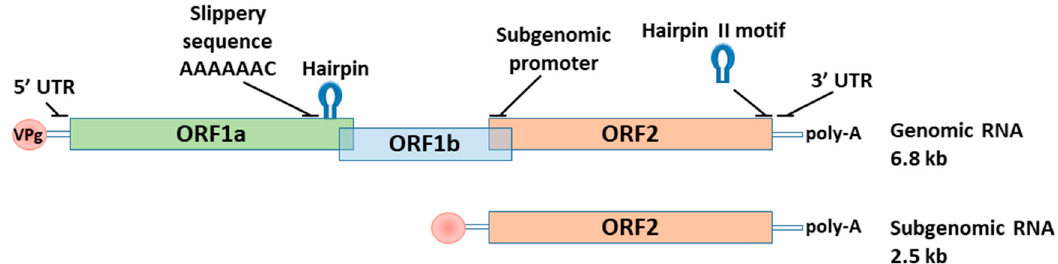
Figure 3. Genome structure of astrovirus. The hepanucleotide slippery sequence and the RNA hairpin structure acts as the frameshifting signal that produces ORF1b translation. ORF2 is a subset of sgRNA produced during virus replication.